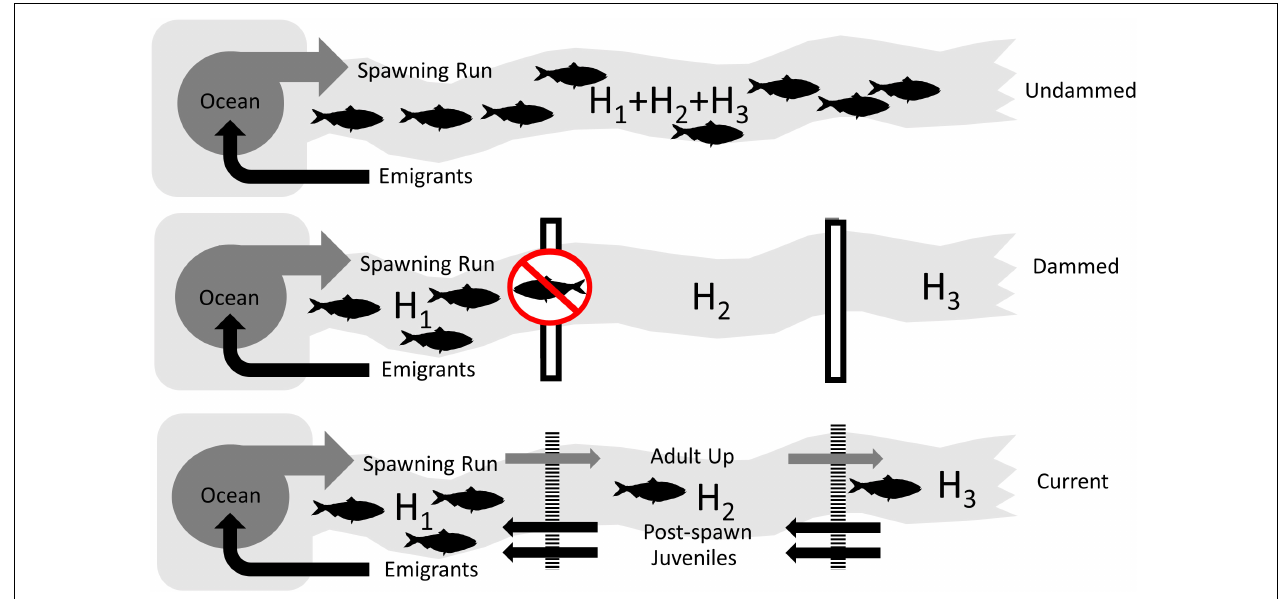
FIGURE 3 | Conceptual diagrams of the three scenarios used to assess the impact of lost habitat and reduced connectivity on the coast-wide production potential of American shad due to dams. The Undammed scenario represents habitat accessibility in the historically undammed rivers. The Dammed scenario depicts the access to habitat that is not impacted by extant impoundments (assuming worst case, non-existing passage). The Current scenario depicts the status quo , where the current array of dams is in place, but upstream and downstream passage is applied at levels that represent the “best case” for American